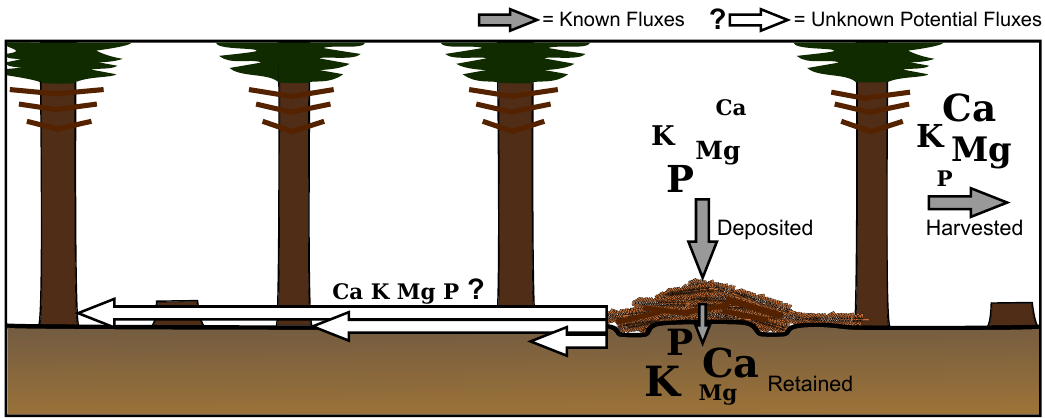
Figure 6. The majority of base cations were exported in harvested stem wood and bark while the majority of P was deposited on the skid trail in branches and needles . Of deposited nutrients, majorities of Ca, K, and P were transported into mineral soil. With Norway spruce’s rooting structure, minimal compaction, and no significant relations between needle nutrient concentrations and distance to skid trail, uptake of nutrients throughout the stand was possible yet